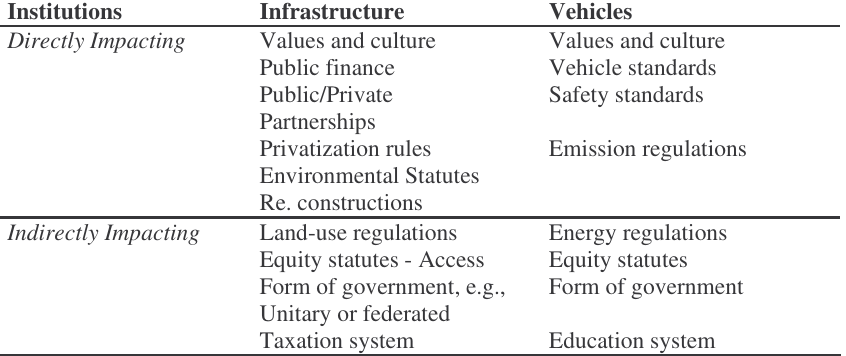
Table 1. Direct and Indirect Institutions by Transport Infrastructure and Vehicle